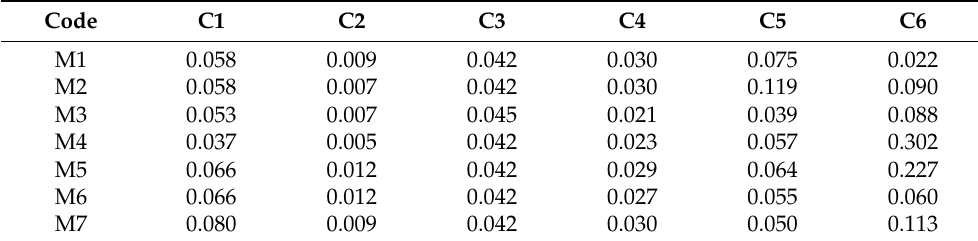
Table 9. Standardized VIKOR weight matrix.